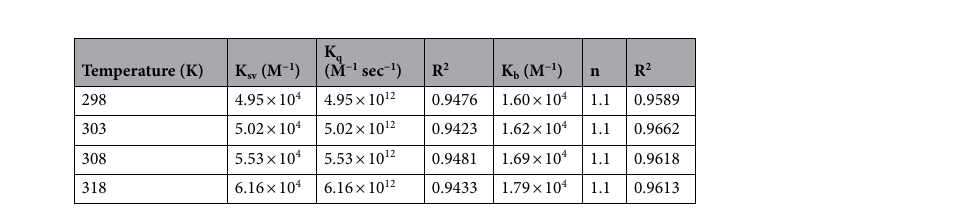
Table 1. Various parameters of measuring the interaction between